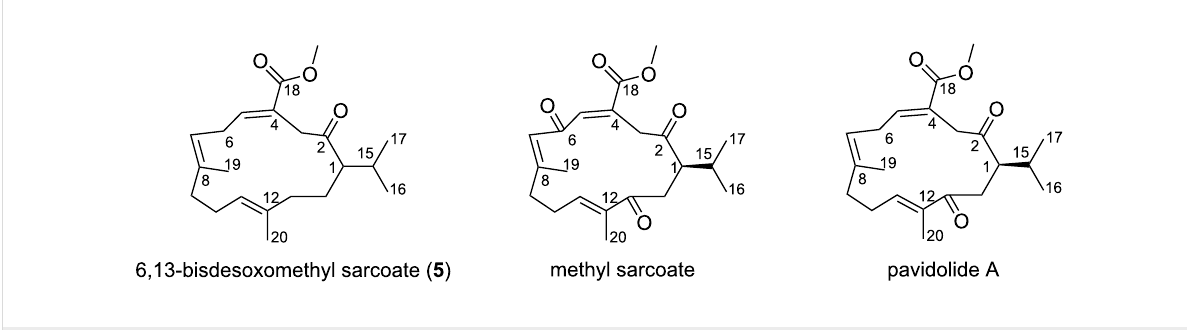
Figure 7: Compound 5 and the most closely related cembranoids from soft corals.